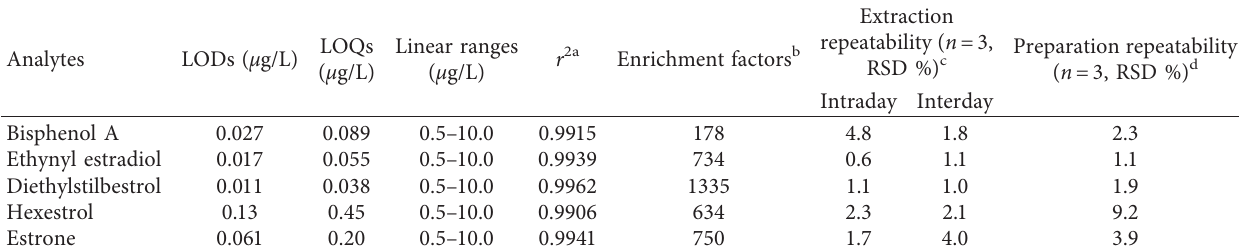
Table 2: Analytical performances of the in-tube SPME-HPLC method for the detection of five estrogens. Analytes